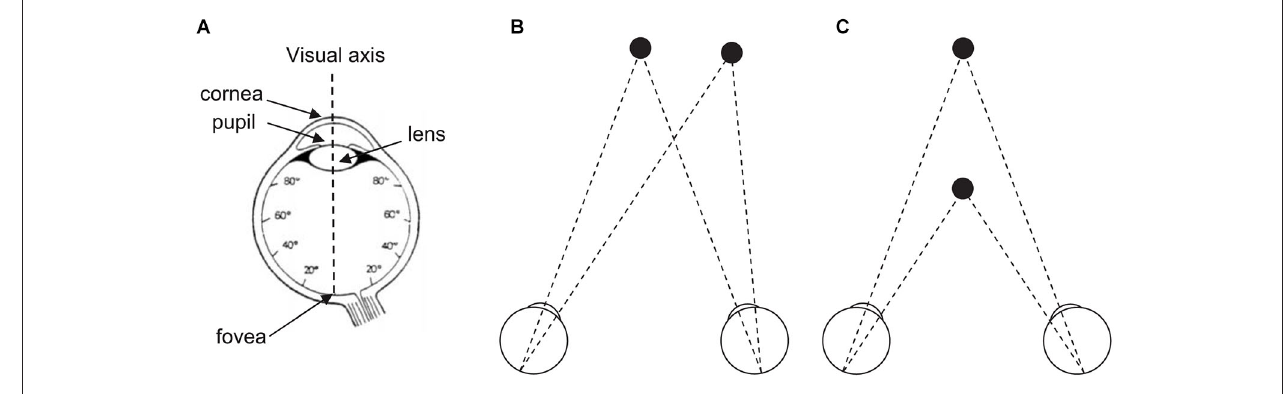
(saccade) or smooth (pursuit) movement to foveate a target in eccentricity (to the left, to the right, up, down, or in any oblique direction). (C) The two eyes move in depth thanks to a step or smooth (vergence) movement to foveate a target in distance (at close or at far). (A) Adapted from Bagot (1999, p. 128, Figure 35) (© O.A. Coubard, with permission); (B,C) From O.A.